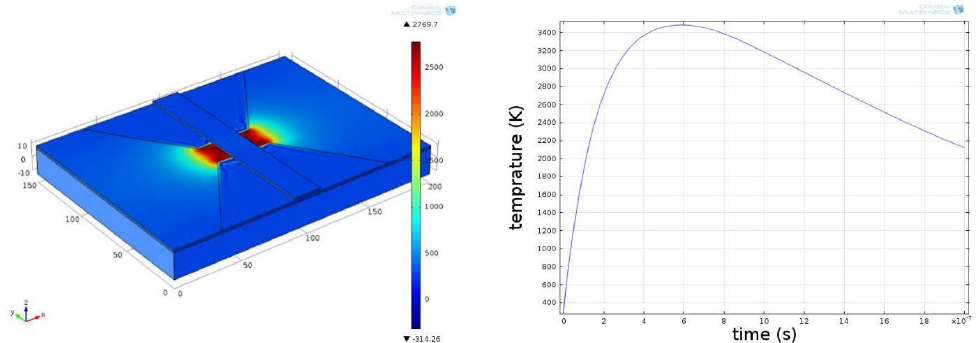
Figure 4. Simulation results of solid-state ON-OFF switch based on electrical explosion.